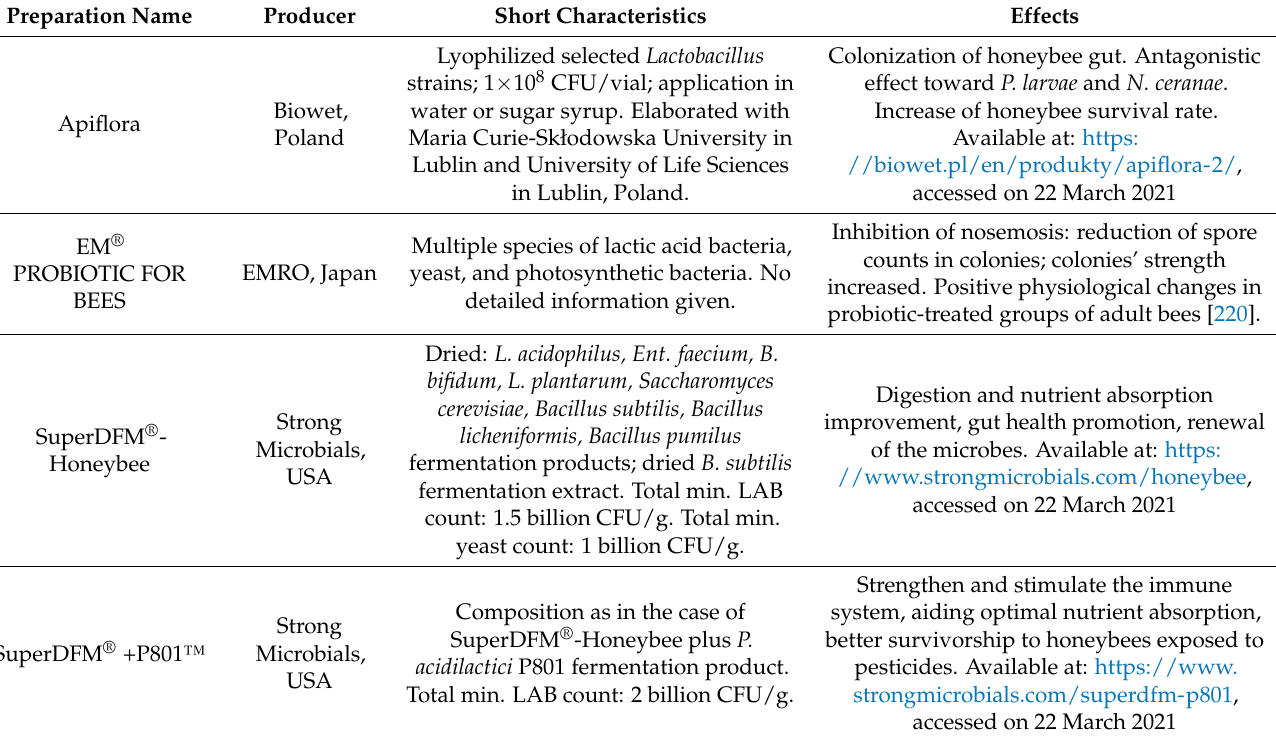
Table 2. Short screening of probiotic honeybee supplements